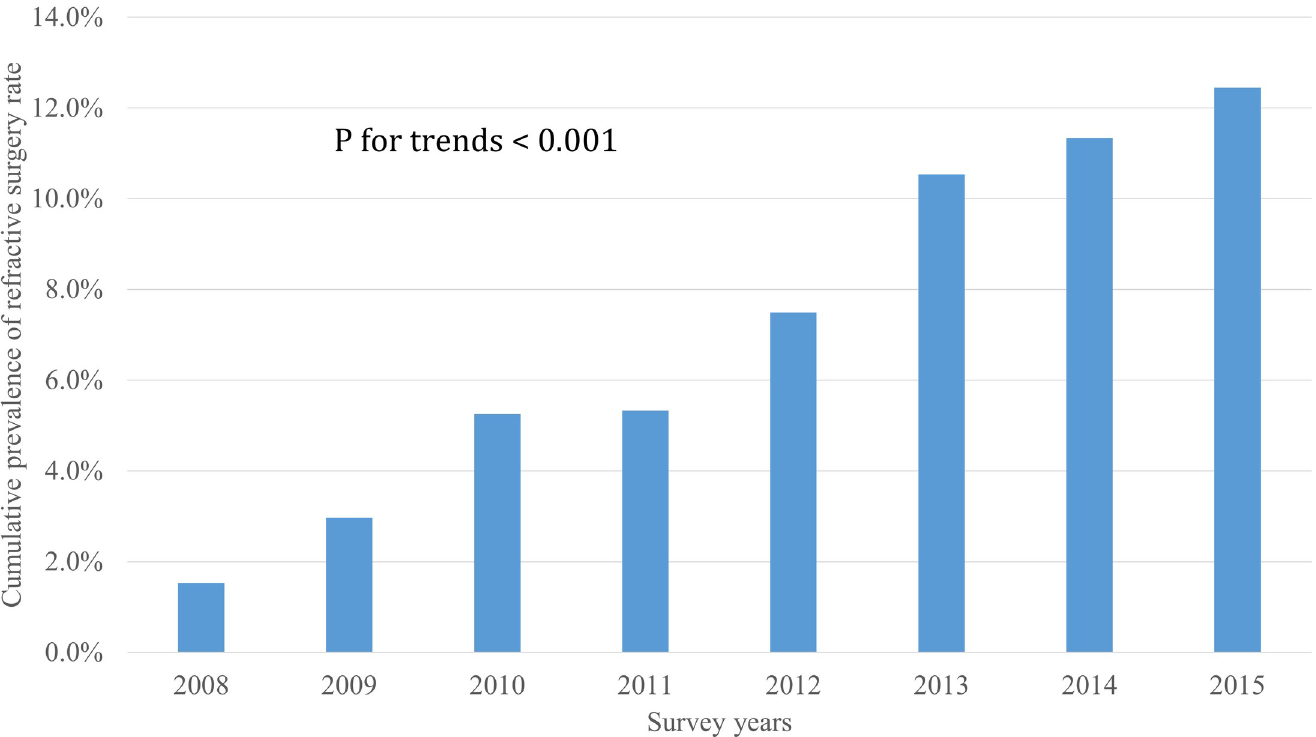
Fig 1. Cumulative prevalence of refractive surgery rate by survey years, KNHANES 2008–2015. The cumulative proportion of participants who underwent refractive surgery showed an increasing trend. P for trends < 0.001.